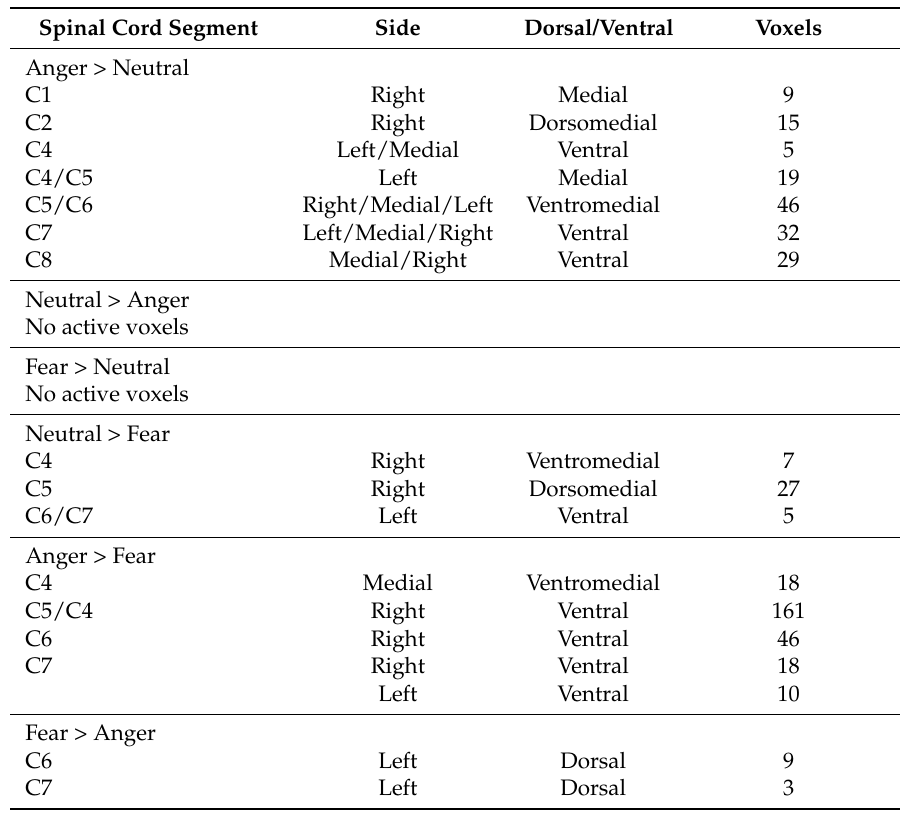
Table 2. Location of spinal cord activity in the contrasts for the conscious perception of neutral, angry, and fearful faces. Results are presented at p < 0.0056; results containing 1 or 2 voxels have been excluded as they are likely false